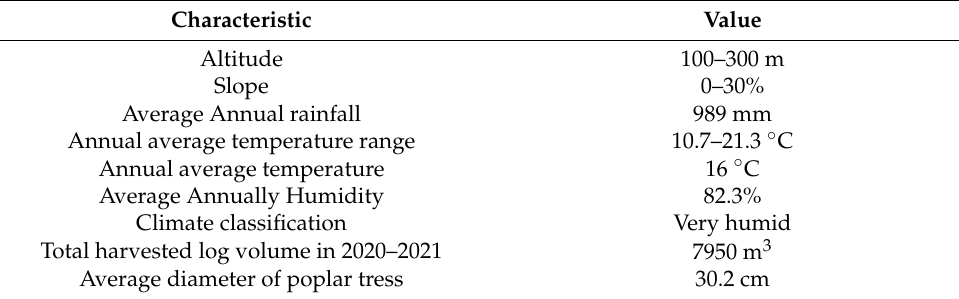
Table 1. Study area